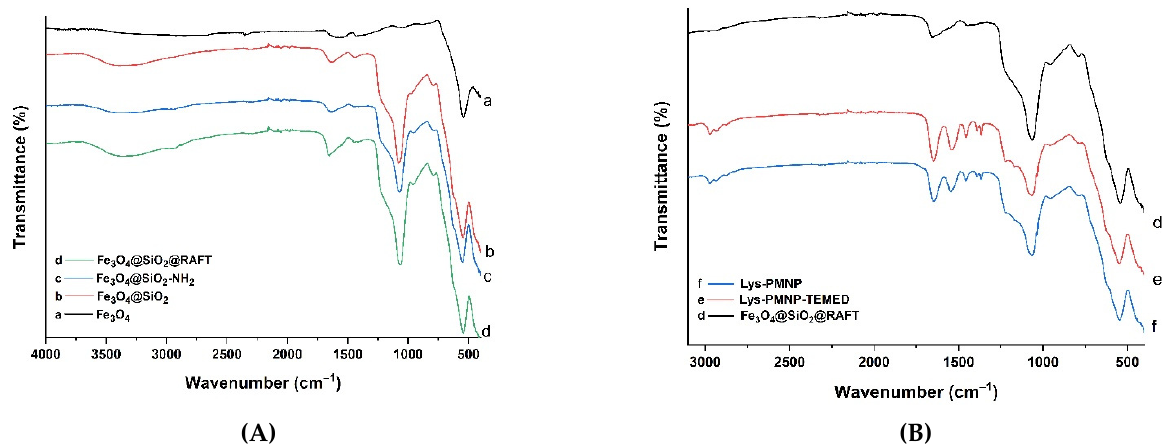
Figure 2. ( A ) FT-IR spectra of Fe 3 O 4 ( a ), Fe 3 O 4 @SiO 2 ( b ), Fe 3 O 4 @SiO 2 -NH 2 ( c ), Fe 3 O 4 @SiO 2 @RAFT ( d ) in the 4000–400 cm − 1 range; ( B ) FT-IR spectra of Fe 3 O 4 @SiO 2 @RAFT ( d ), Lys-PMNP-TEMED ( e ) and Lys-PMNP ( f ) in the 3100–400 cm − 1 range.